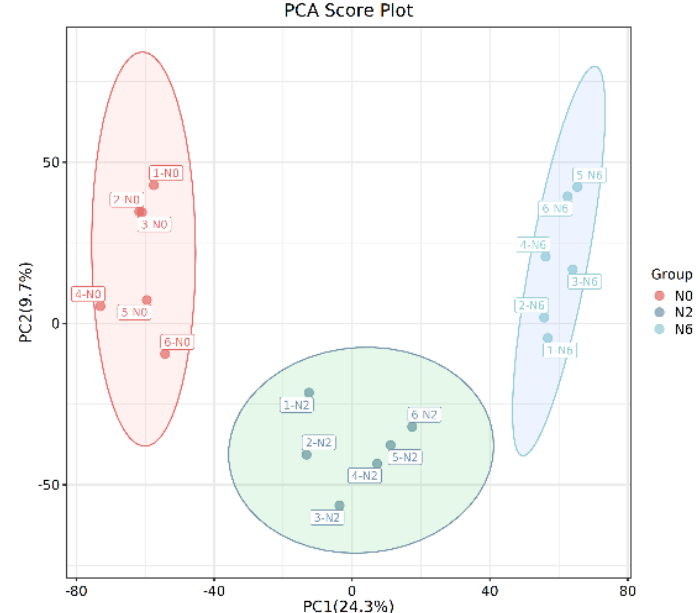
Figure 2. The PCA score plot.